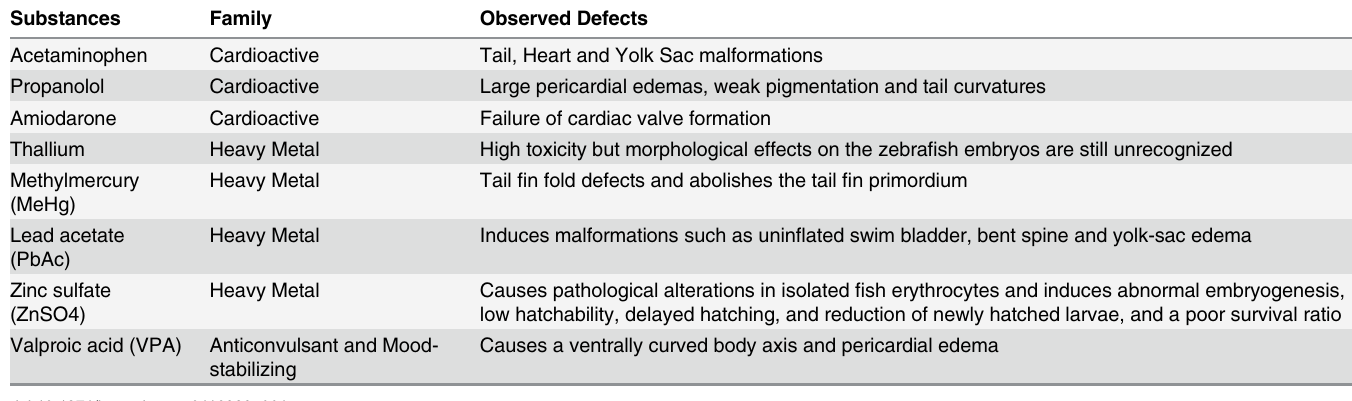
Table 1. Summary of the effects of the substances used to intoxicate the zebra fi sh